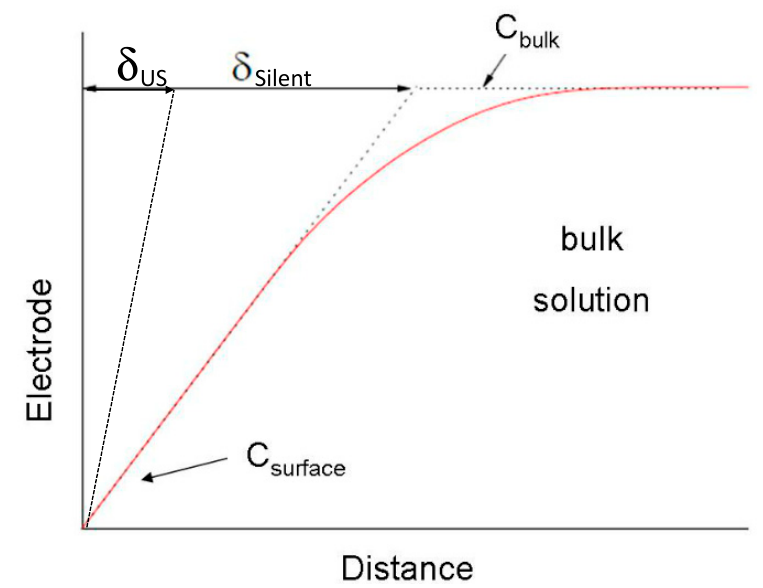
Figure 5. Concentration profiles and the diffusion layer thickness ( δ ) in the presence of ultrasound ( US ) and in the absence ( silent ).